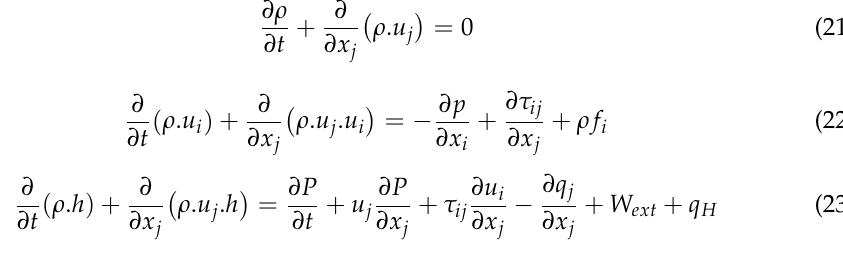
Figure 15. Specified boundary conditions for the finite element analysis (FEA), fixed support ( a ) and rotational speed and its axis ( b ).